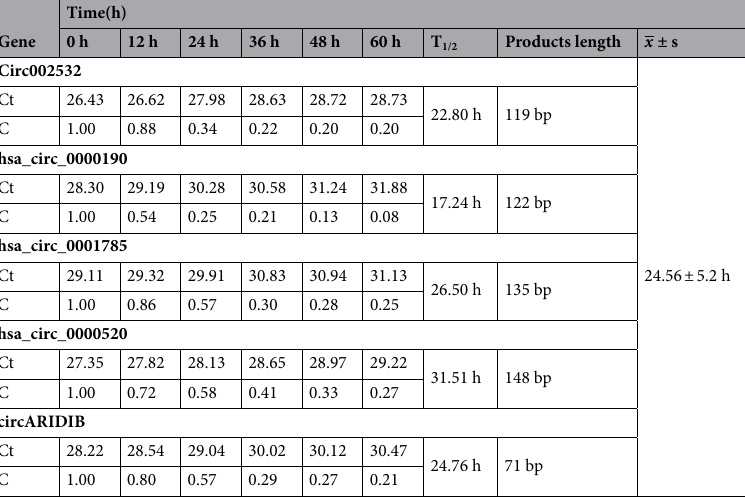
Table 6. Changes in circRNAs concentration in whole blood at room temperature. The 95% confidence interval for T 1/2 was calculated to be (20.002,